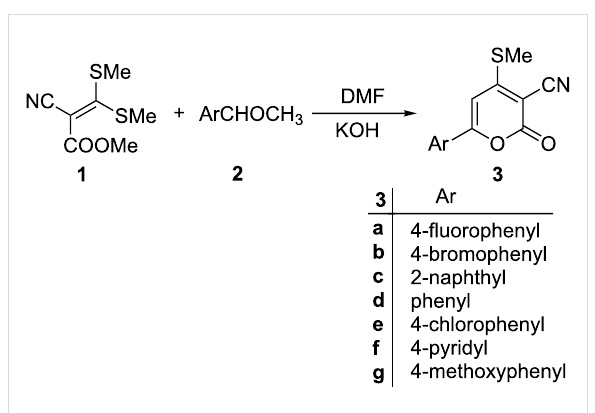
Scheme 1: Syntheses of 6-aryl-4-methylthio-2 H -pyran-2-one-3- carbonitriles 3